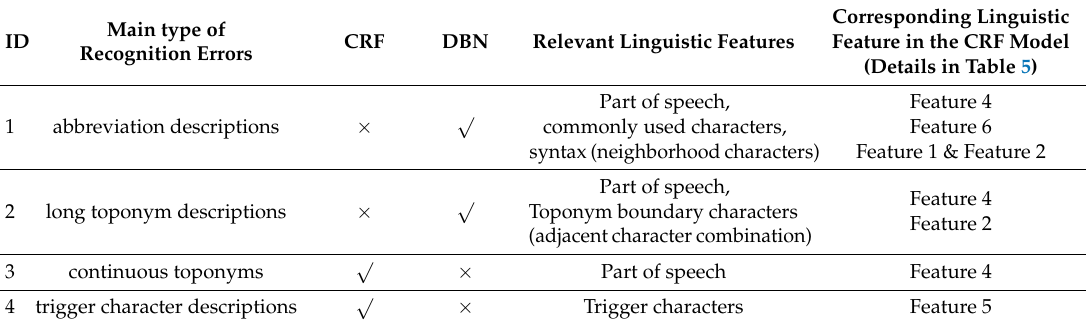
Table 7. Main types of recognition errors and their relevant linguistic